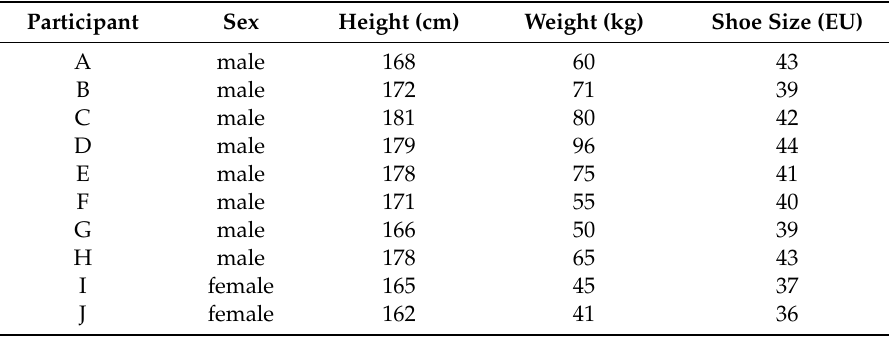
Table 1. Body conditions of the participants in the experimental